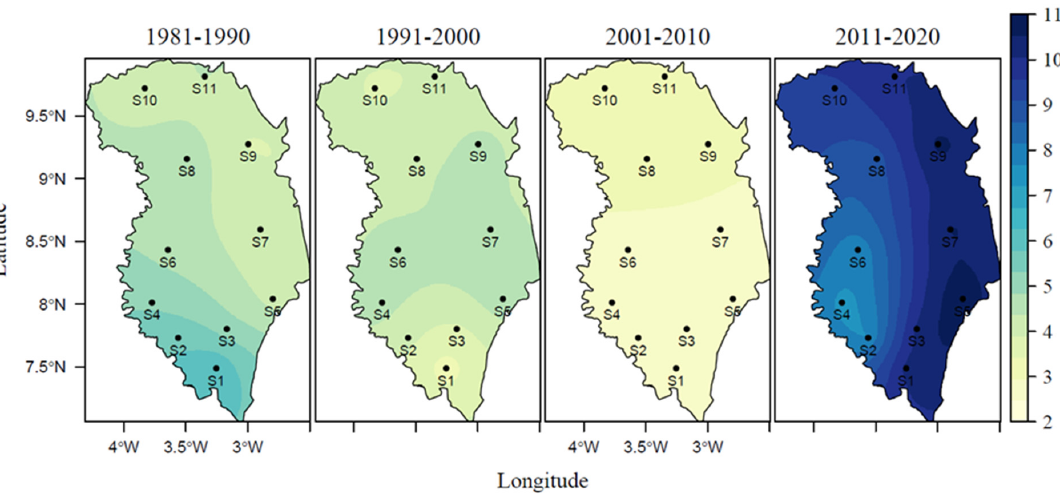
Figure 7. Spatial distribution of the contribution of extremely wet days (R99pTOT) (%) per decade in the Zanzan region. Stations (S1 = Koun Fao, S2 = Kouassi-dat é kro, S3 = Tanda, S4 = Sandegu é , S5 = Bondoukou, S6 = Nassian, S7 = Sapli, S8 = PN Como é S1, S9 = Bouna, S10 = T é hini, S11 =